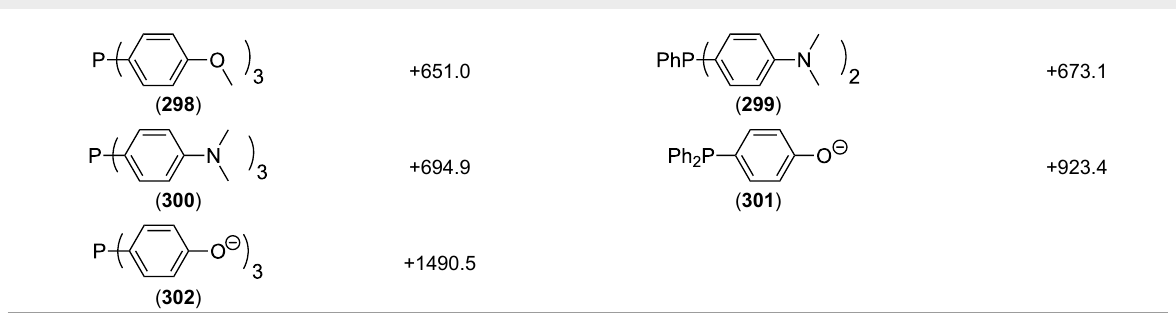
Table 6: MCA values of aryl-substituted phosphanes. (continued)